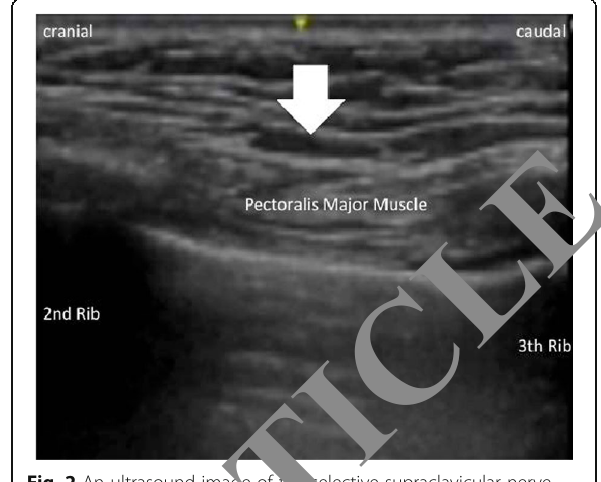
Fig. 2 An ultrasound image of the selective supraclavicular nerve block. An injection point is a white arrow